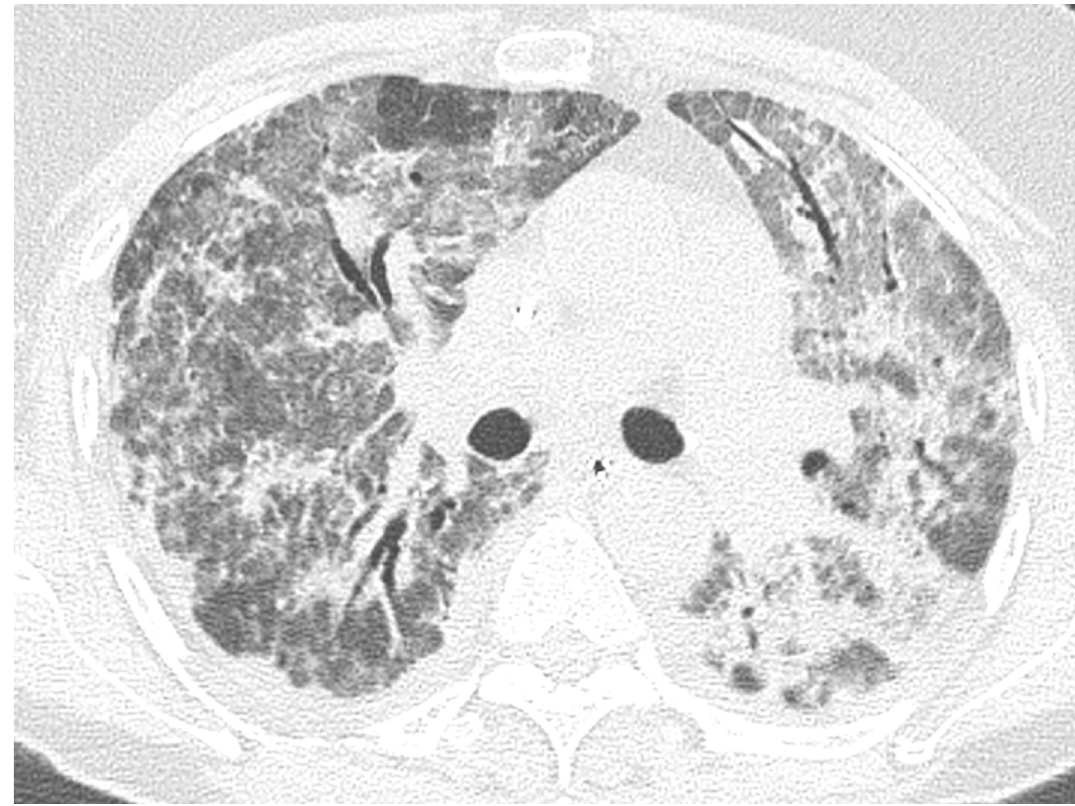
Fig 3. Air bronchogram. Axial reconstructions of a CT in lung window showing air